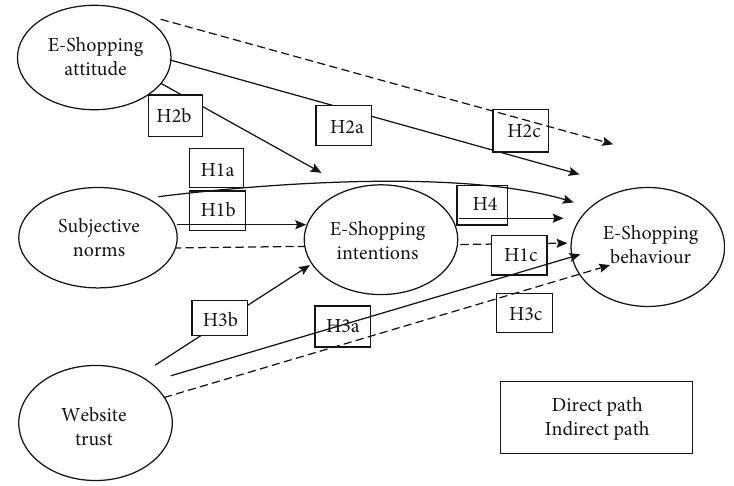
Figure 1: Diagrammatical representation of relationship between study variables (theoretical